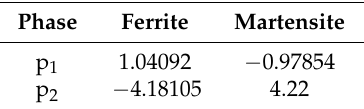
Table 3. Fitting coefficients of each phase.